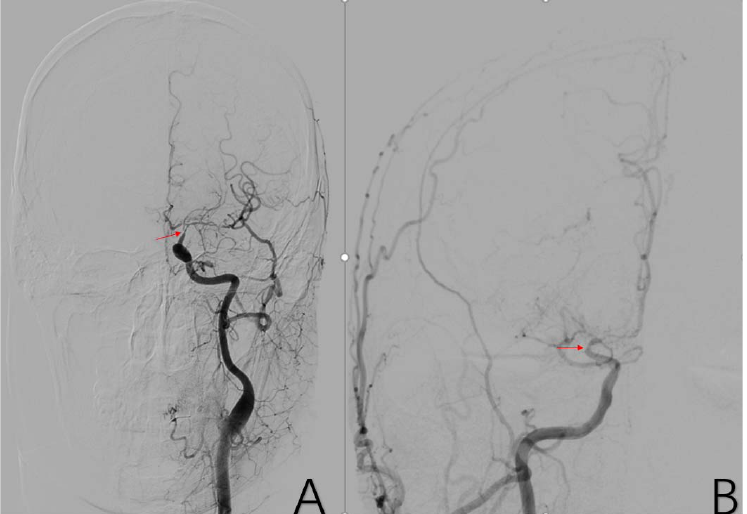
Figure 4. ( A ) is a 48 ‐ year ‐ old male. The typical image presentation of internal carotid artery stenosis can be demonstrated on this DSA of the common carotid artery. Additionally, there was a typical